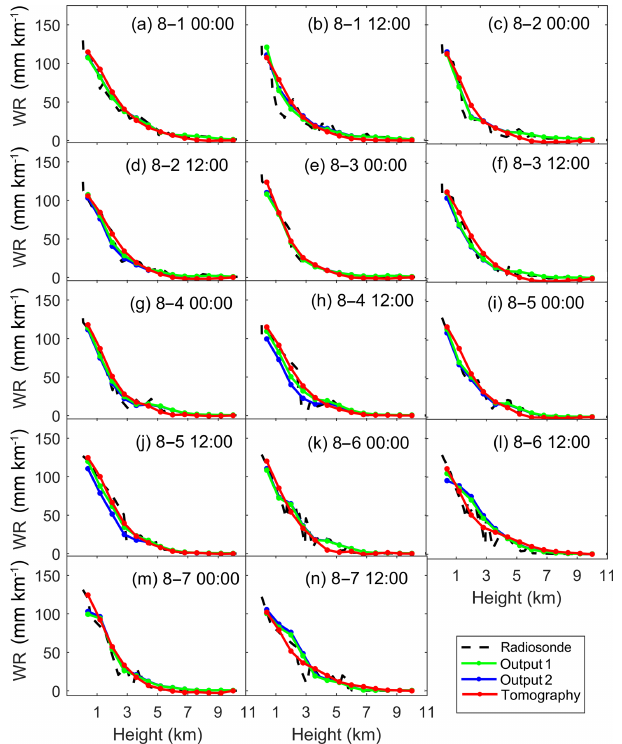
Figure 6. Statistics of bias, SD, and rms of the tomography, Out- put1, and Output2 validated by the